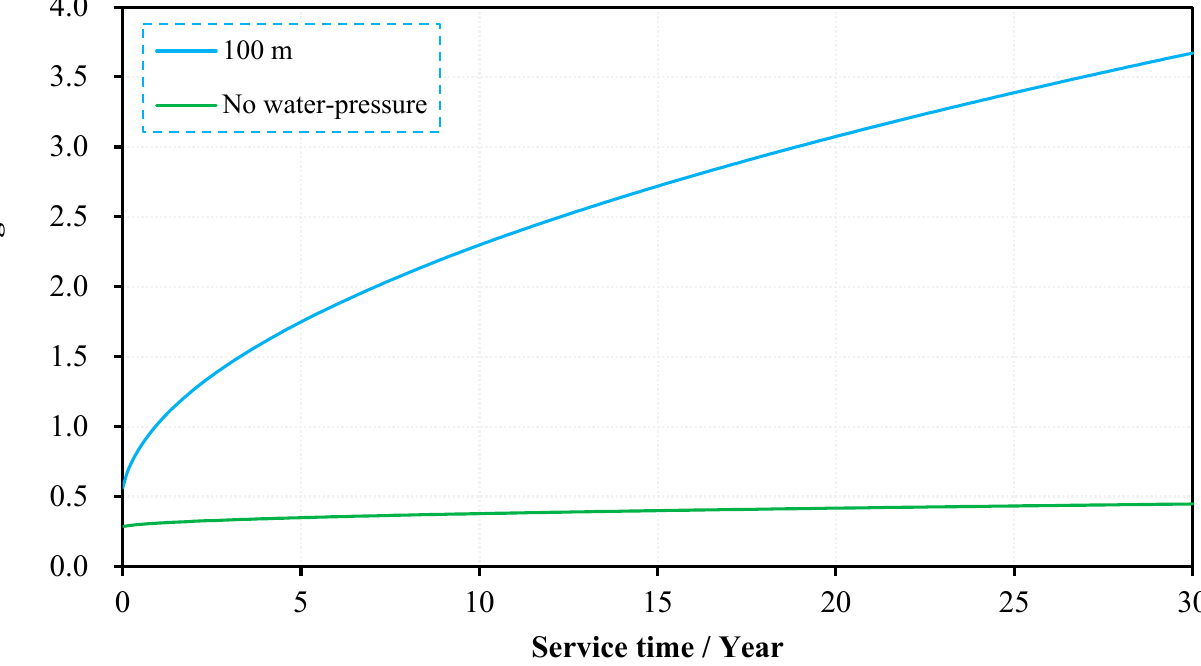
Figure 4. Cumulative leakage in the coal pillar of the underground reservoir.